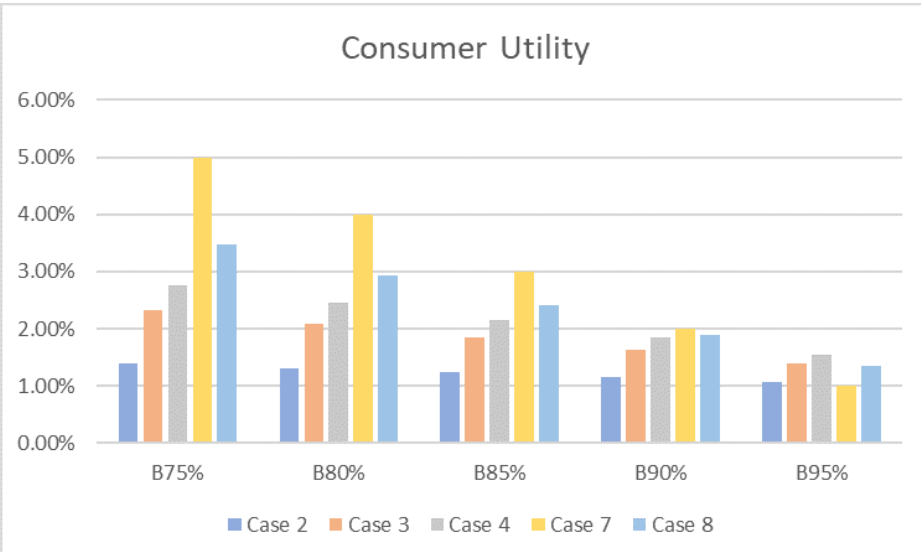
Figure 6. Comparative behavior in weighted scenarios: aggregator benefit.